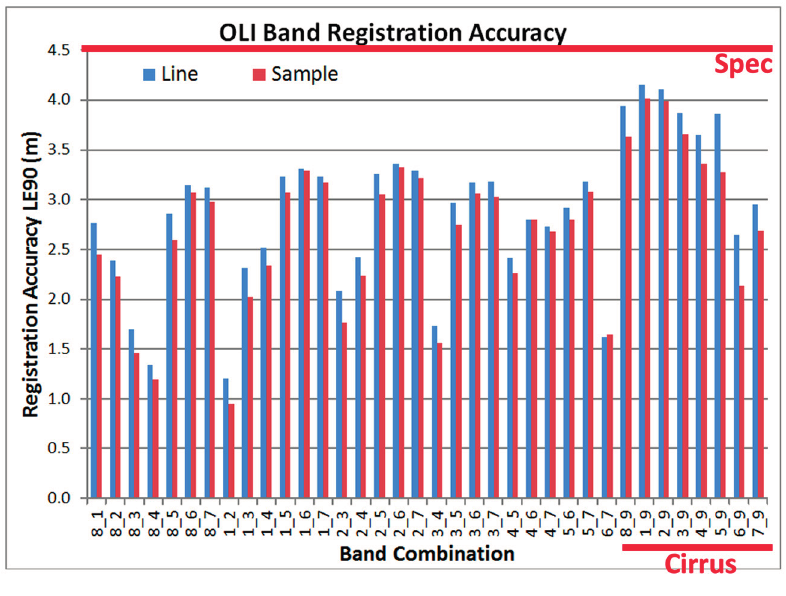
Figure 24. Coregistration for both imagery lines and individual samples was well below a quarter pixel (plot courtesy of Jim Storey,